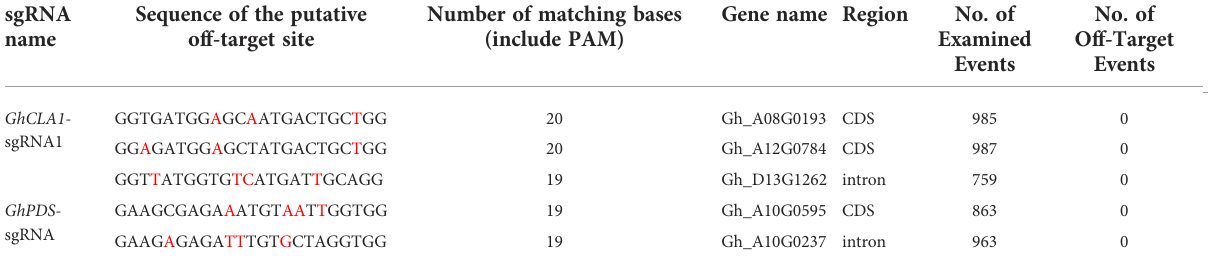
TABLE 1 Detection and analysis of fi ve potential off-target